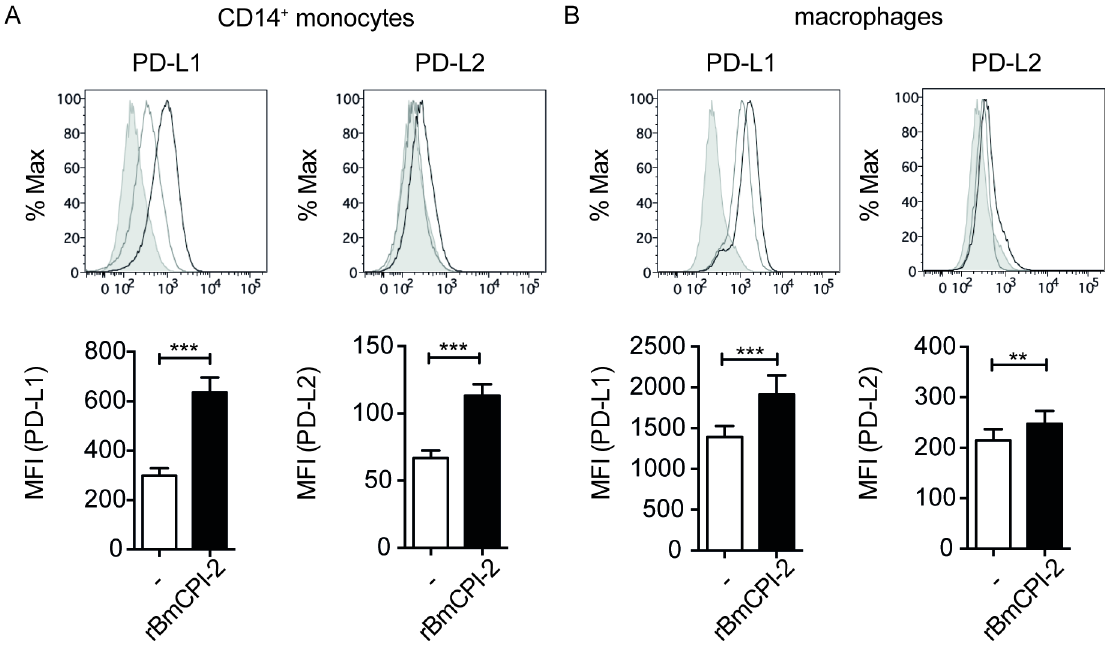
Fig 2. rBmCPI-2 induces expression of PD-L1 and PD-L2 on human monocytes and macrophages. Monocytes(A) or macrophages (B) were left unstimulated or stimulatedfor 24 h with 20 μ g/ml of recombinant BmCPI-2 (n = 12). Surface expressions of PD-L1 and PD-L2 were measuredby flow cytometry. Histograms in the upper panel show representative plots of unstained(grey tinted), unstimulated (grey line) and stimulatedcells (black line). Bar graphs in the lower panel show the mean fluorescence intensity (MFI). All data are representedas mean ± SEM. P values were calculatedusing Wilcoxon signed-rank test. ** p < 0.01, *** p < 0.001.